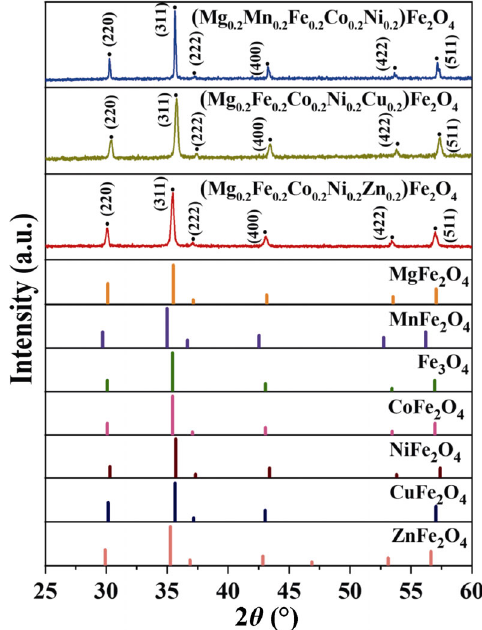
Fig. 1 XRD patterns of the three HE MFe 2 O 4 together with those of MgFe 2 O 4 , MnFe 2 O 4 , Fe 3 O 4 , CoFe 2 O 4 , NiFe 2 O 4 , CuFe 2 O 4 , and ZnFe 2 O 4 obtained from ICDD/JCPDS cards.